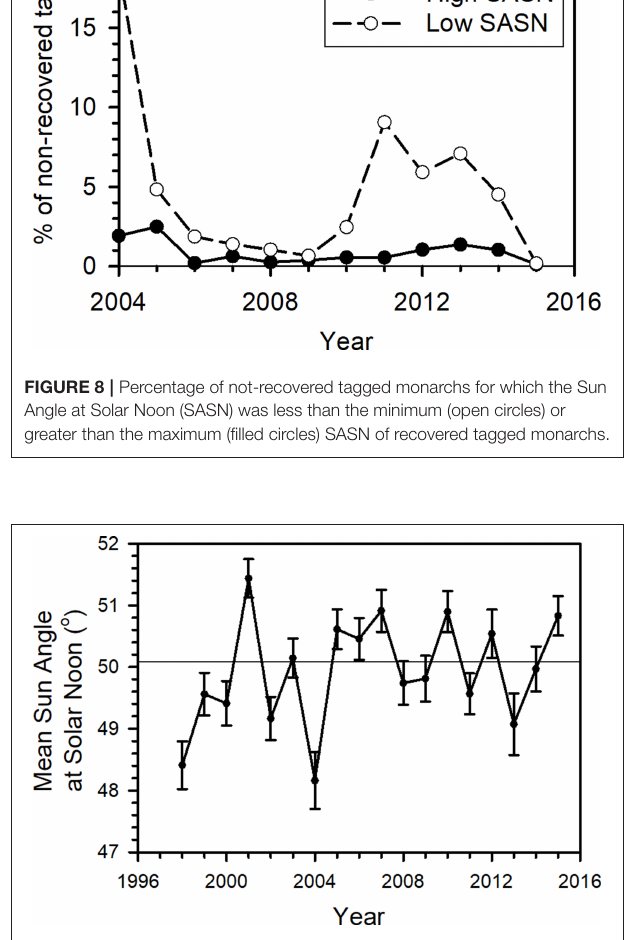
FIGURE 9 | Mean Sun Angle at Solar Noon (SASN) ( ◦ ) ( ± 95% confidence interval) by year for all data, wild-caught and reared tagged between 1998 and 2015 in the Monarch Watch program. Horizontal line represents mean of yearly